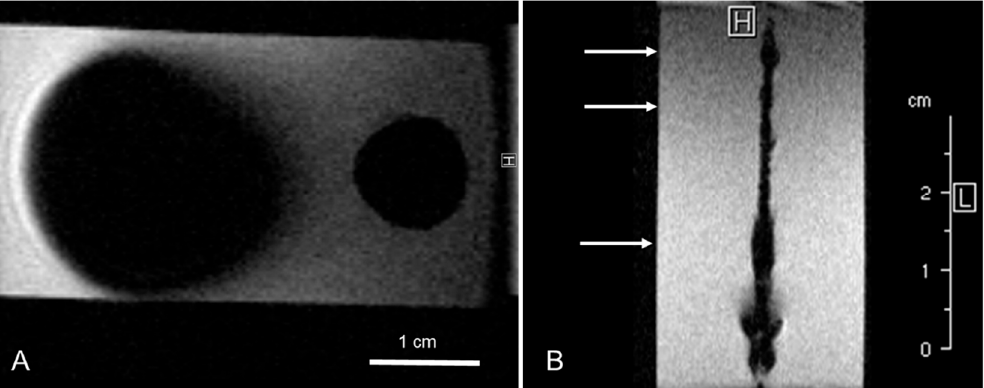
Figure 1. MRI image of varnish samples with a volume of 4 mm³ ( A ) with Bayoxide E8706 (left) and KLB particles (right). The resulting signal voids are comparably larger for Bayoxide E8706 than for KLB. ( B ) A guidewire with three KLB markers in different concentrations (c(Fe) = 2.4 mg/mL, 1 mg/mL and 0.5 mg/mL). In contrast to ( A ), the amount of KLB particles on the guidewire caused no sufficient signal voids at the real marker positions (arrows). The beading at the bottom end is probably caused by contamination of the sample. The B 0 field direction was perpendicular to the imaging slice.